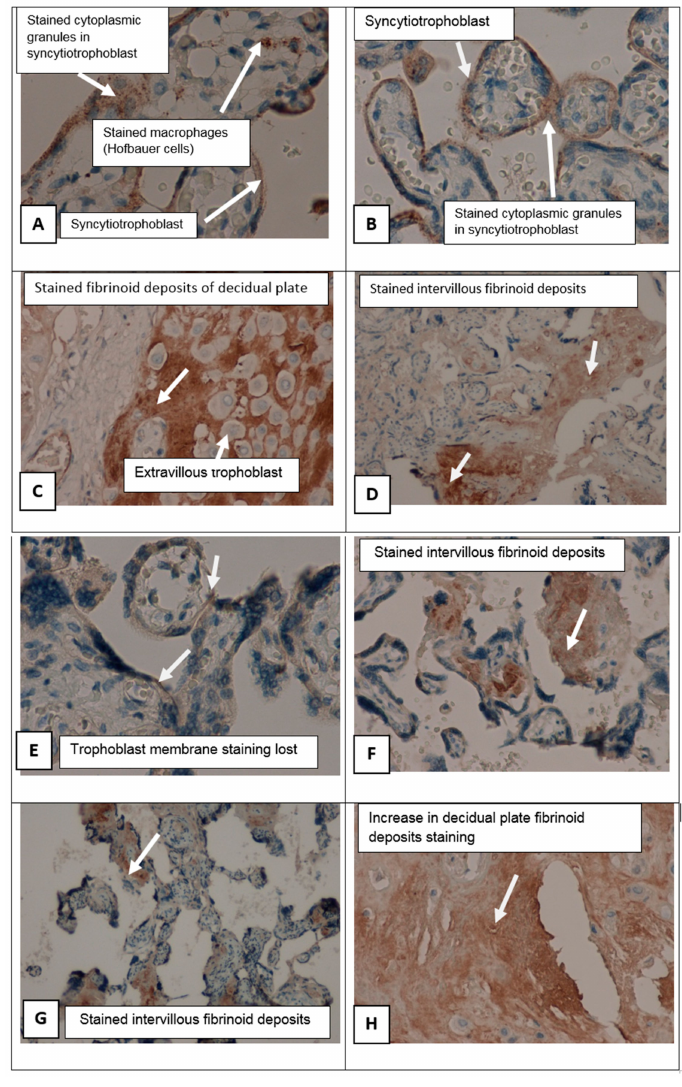
Figure 3. SERPINA1 expression in placenta samples in cases of preeclampsia. ( A )–( D) Placenta villi in PE in the group with no SERPINA1 peptides in urine, stained granules, and membrane expression were determined. Fibrinoid deposits were stained, as well. ( A , B ) × 400; ( C , D ) × 200. ( E )–( H ) Placenta villi in PE in the group with SERPINA1 peptides in urine; membrane expression was lost. Fibrinoid deposits were stained also. ( E ) × 400; ( F ) × 200; ( G ) × 100; ( H ) ×